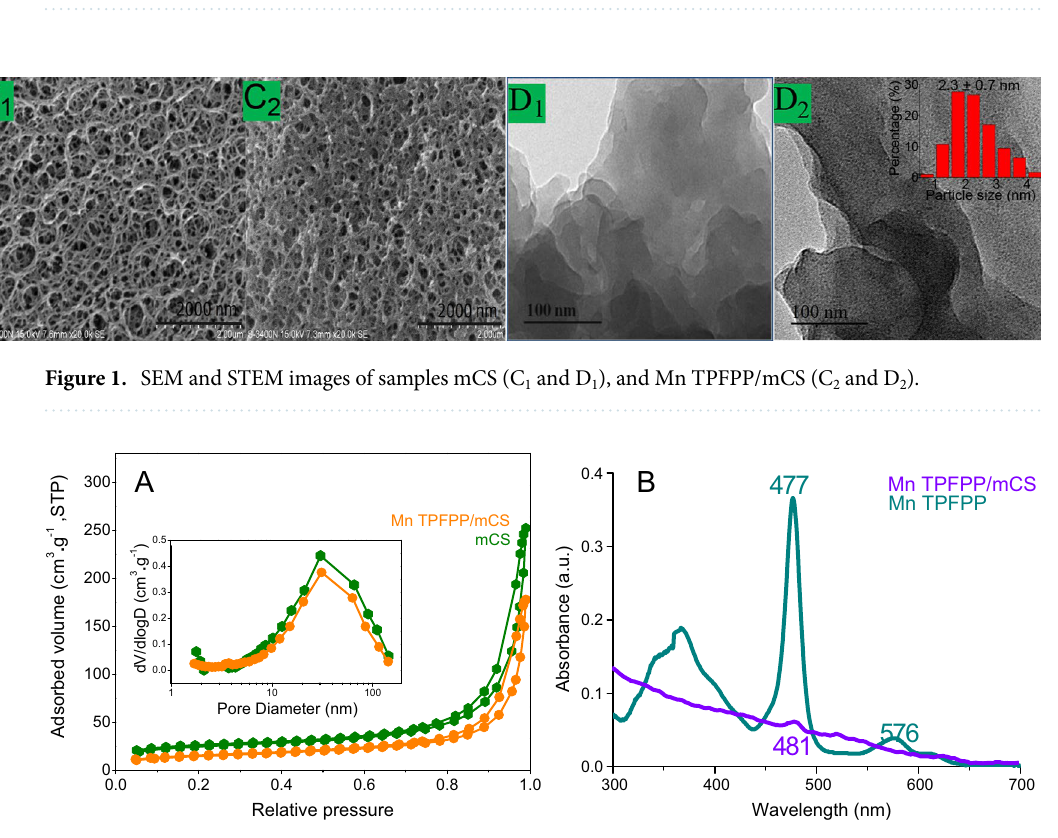
Figure 2. ( A ) Nitrogen adsorption–desorption isotherms for the mCS (a) and the Mn TPFPP/mCS (b). Inset shows the pore size distributions. ( B ) UV–Vis spectra of dichloromethane solution of Mn TPFPP, and dichloromethane suspension of Mn